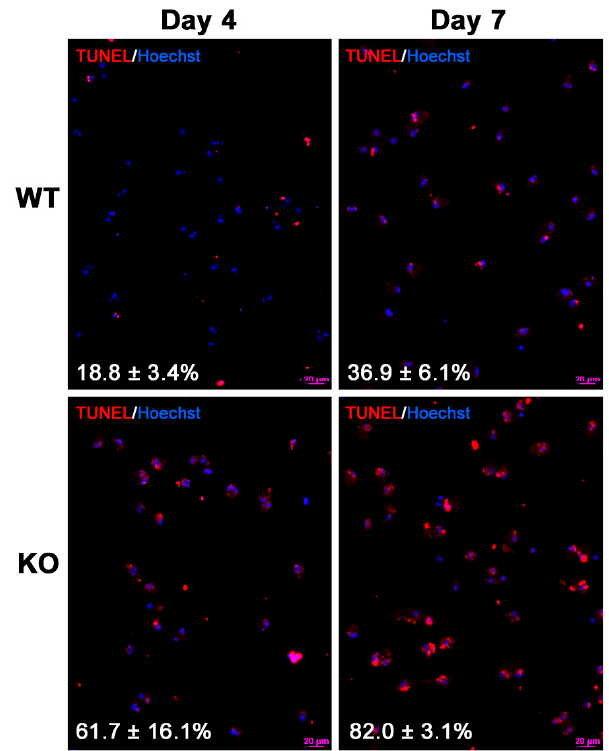
Figure 7. Sertoli cells from 8-month-old Arsa KO mice underwent higher rates of apoptosis in culture than Sertoli cells from age-matched WT males. Sertoli cells from Arsa KO and WT mice were cultured in parallel and the TUNEL assay was performed on culture day 4 and day 7. Fluorescent images of Sertoli cells from WT and KO mice showing incorporation of TMR-dUTP (red fluorescence) into the nucleus (Hoechst blue fluorescence) were displayed along with percentages of apoptotic cells (TMR-dUTP positive) in the bottom left. Results were from 3 replicate experiments.